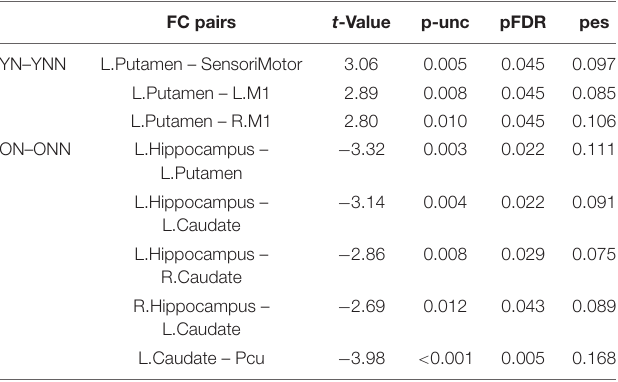
TABLE 2 | Sleep effects on post-MSL FC differences (RS3–RS2) in young and older groups. FC pairs t -Value p-unc pFDR pes